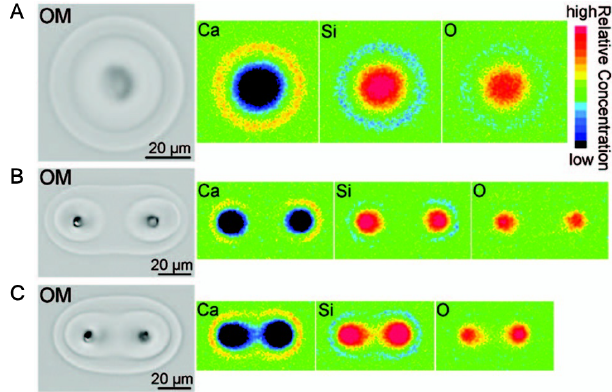
Figure 4: Ion migration due to temperature gradients arising from high-repetition-rate laser (250 kHz) irradiation in 50 CaO - 50 SiO 2 (mol%) glass. The left-hand column shows optical microscope (OM) images of the structures. The corresponding spatially resolved relative concentrations of Ca, Si and O are shown on the right- hand side. (A) Single spot irradiation. (B) Two-spot irradiation with 42.7 µ m separation. (C) Two-spot irradiation with 31.9 µ m separa- tion. With permission from [49]. Copyright 2011 The Optical Society.